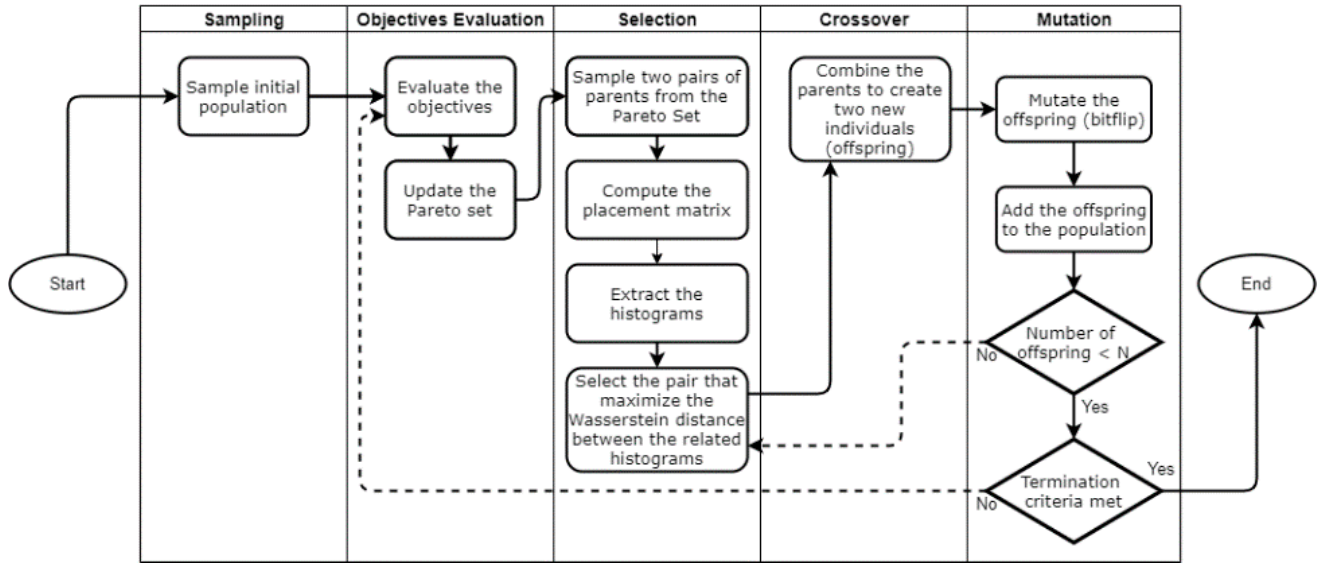
Figure 7. The general structure of MOEA/WST.